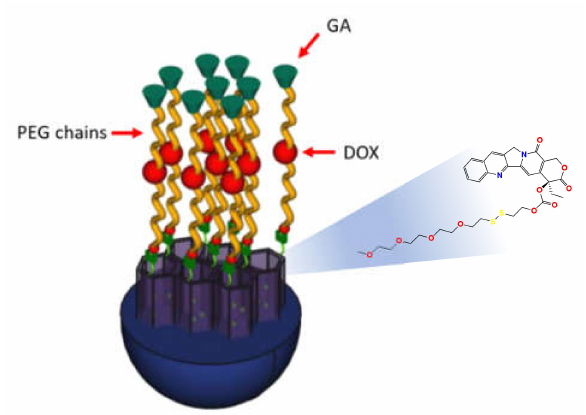
Figure 1. Schematic representation of the drug delivery systems